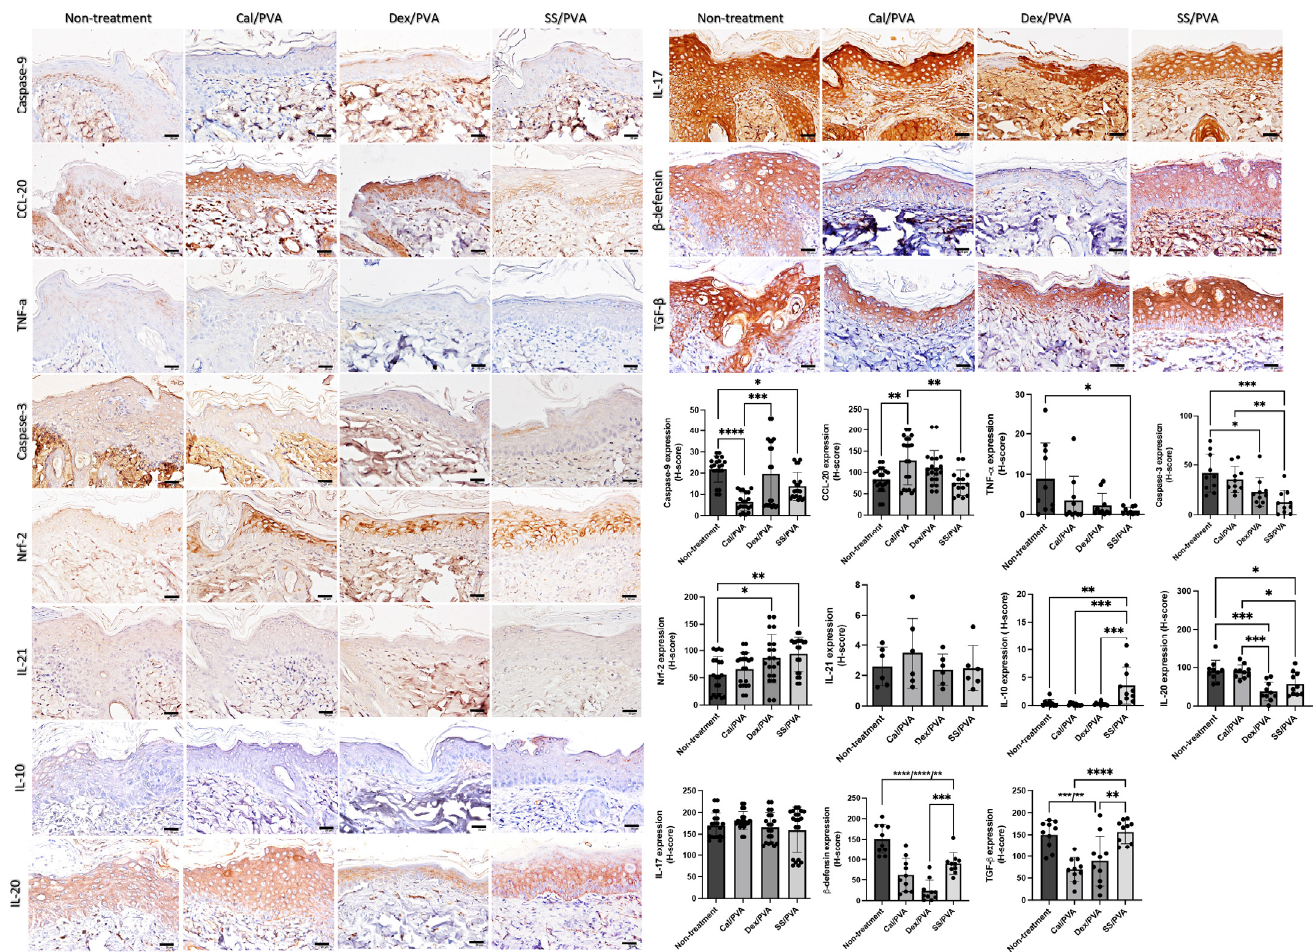
Figure 4. The expression of cytokines and chemokines involved in psoriatic skin determined using immunohistochemical staining . Bar graph of the H-scores using ANOVA; scale bars = 20 μ m. The significant level in the figure was presented as * = p < 0.05, ** = p < 0.01, *** = p < 0.001, **** = p < 0.0001 .